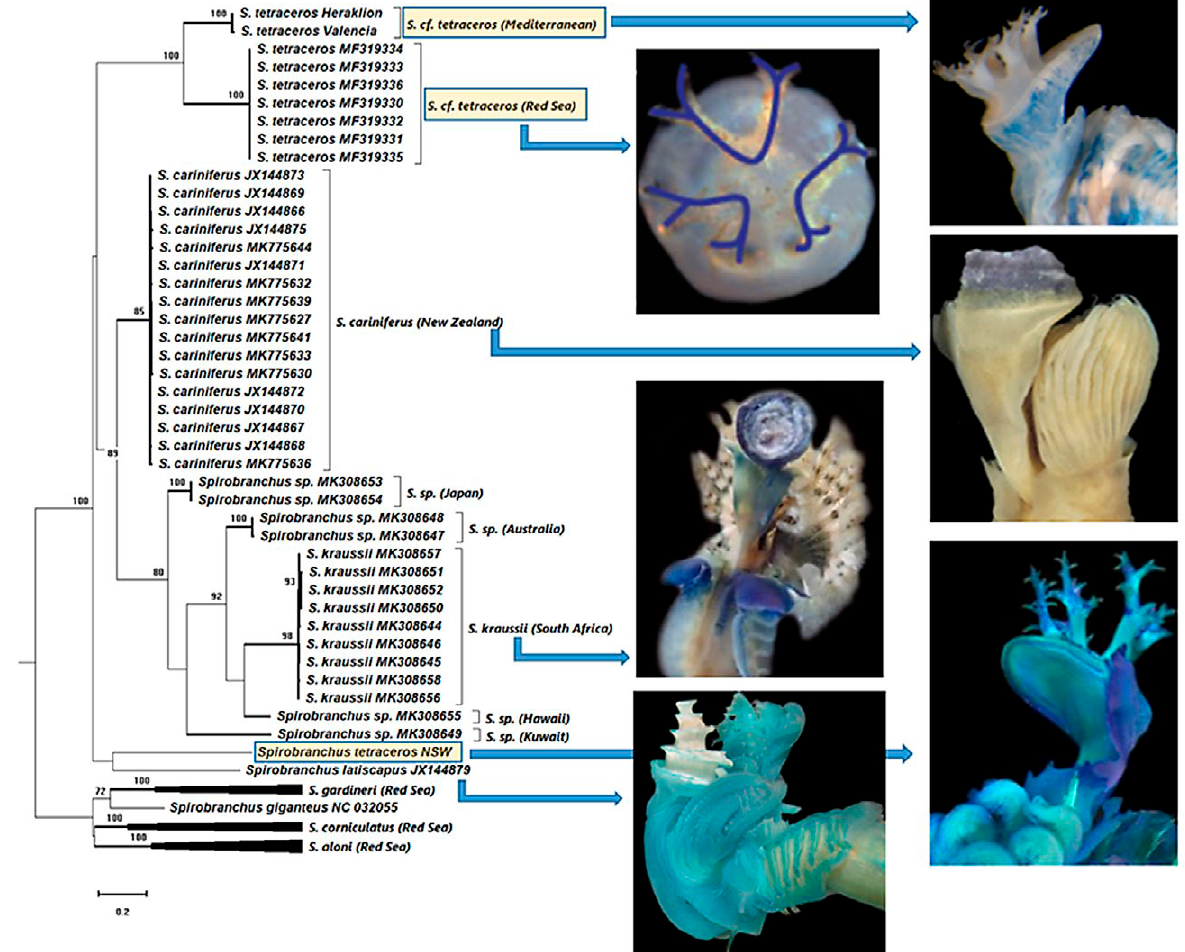
Fig. 2. – Maximum likelihood phylogenetic tree. Only bootstrap support values above 70% are shown. Images for specimens assigned to the Spirobranchus tetraceros complex taken by Aylin Ulman (Mediterranean clade), Orly Perry (Red Sea clade) and Eunice Wong (Australian clade). Photos of Spirobranchus cariniferus and S. latiscapus were taken by Eunice Wong and that of S. kraussii was taken by Carol Simon and modified for presentation